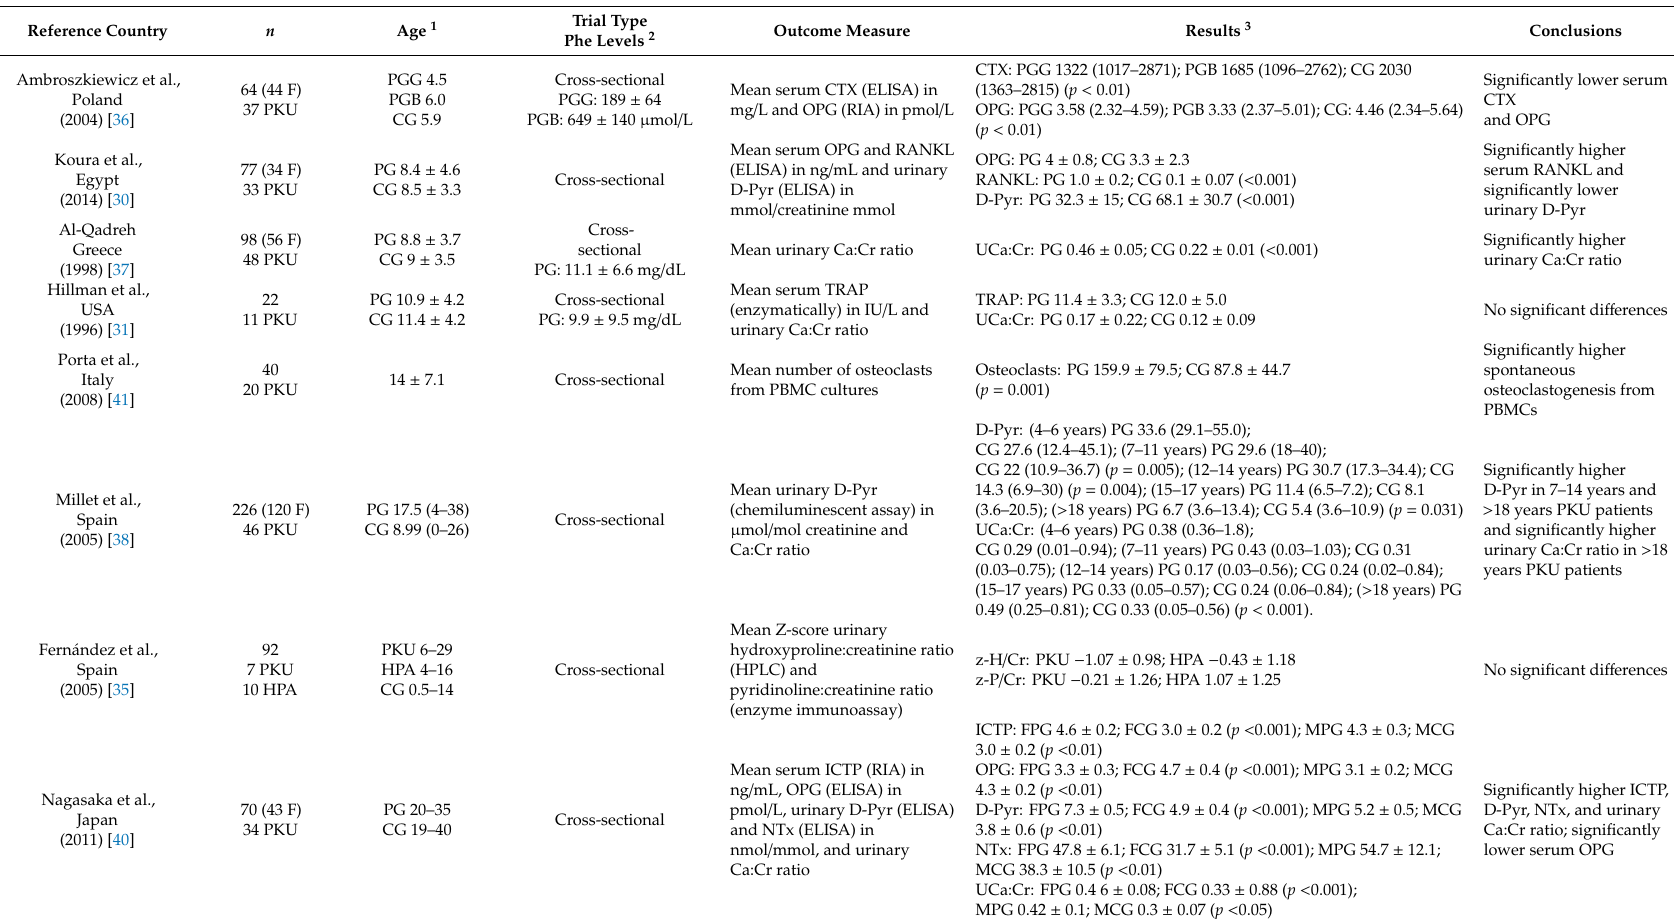
Table 3. Bone resorption in patients with